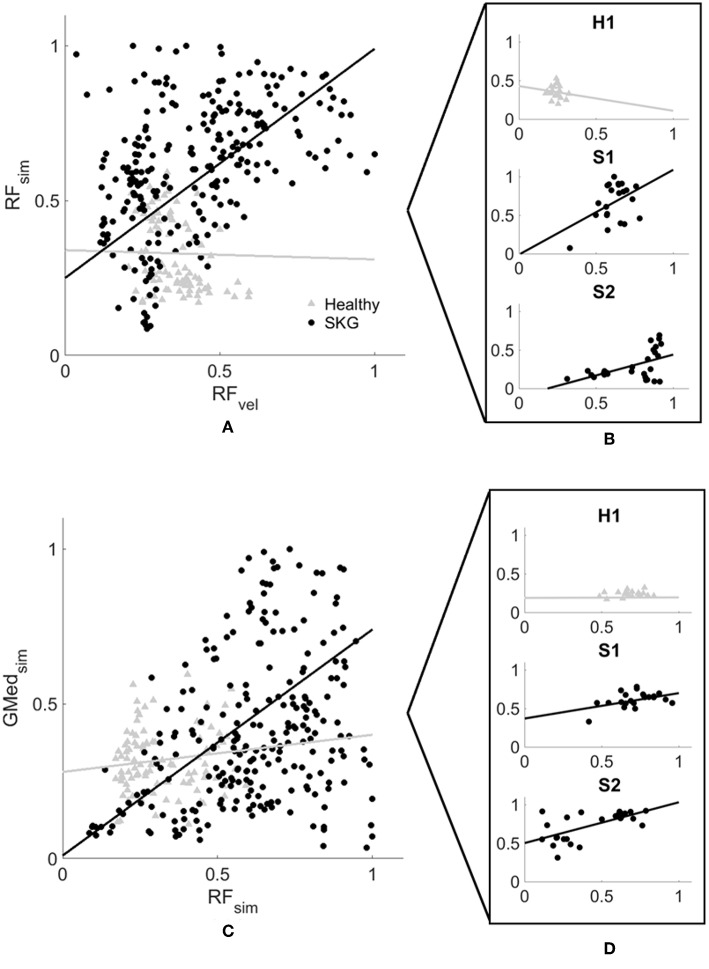
Computed RF activation increases with RFvel
(A,B) and coupled with GMed (C,D) activity in people with SKG. Normalized RF peak stretch velocity (RFvel) values and peak RF activation (A) and coupled GMed activity (C) from every simulated gait cycle in all subjects during the involuntary response period. Individuals with SKG (dark circles) show increased peak RF (βSKG = 0.8) activity and coupled GMed (βSKG = 0.73) activity, as would be expected in a reflex response. However, healthy controls (gray triangles) show a decrease in RF (βHealthy = −0.03) and small increase in coupled GMed (βHealthy = 0.12) activity, suggesting that this abnormal reflexive response did not exist in healthy controls. A representative healthy participant (H1) and two representative subjects with post-stroke SKG (S1, S2) highlight the correlation between RFvel and RF activation profiles (B) and coupled GMed activity (D).